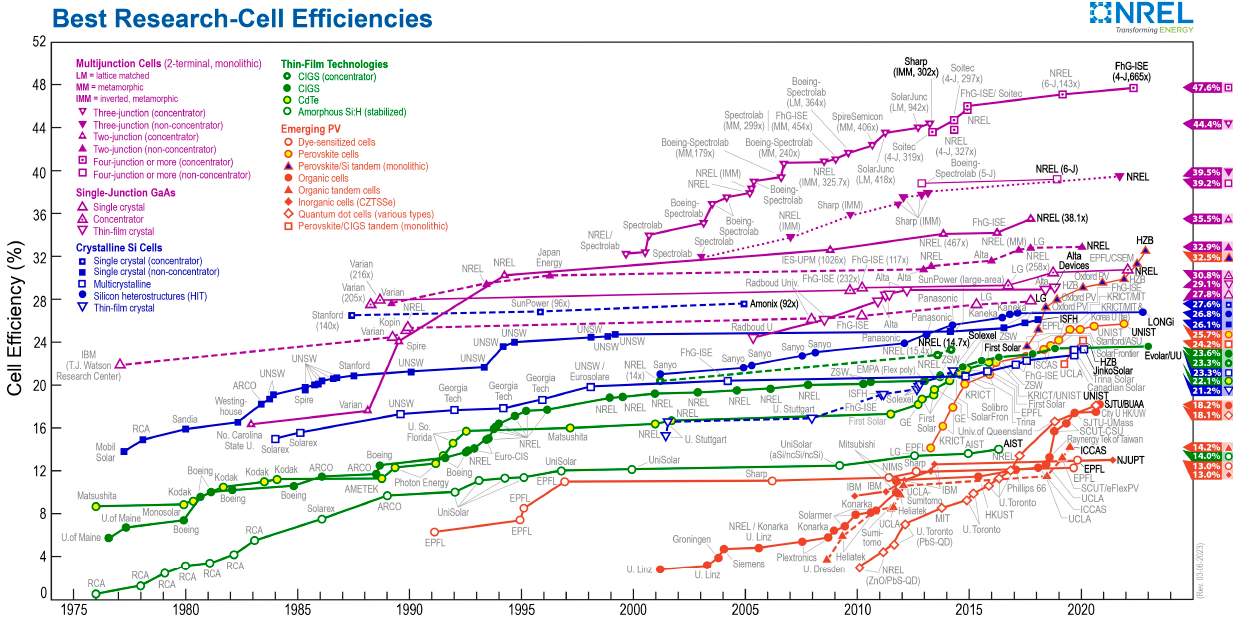
Figure 1. The cell e ffi ciencies of various types of solar PV cells [8].